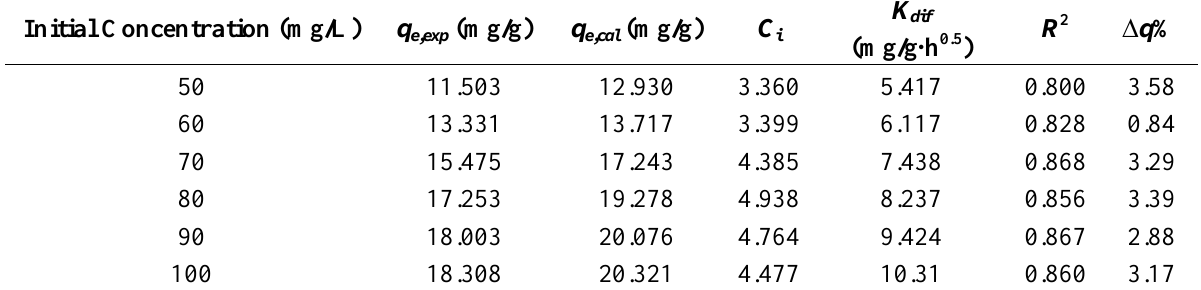
Table 5. The evaluation of the intra-particle diffusion rate constant at 30